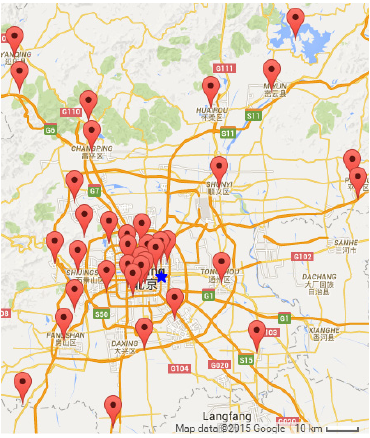
Figure 2. Distribution of Beijing observation stations. Blue star represents the US Embassy (39.92 N, 116.44 E) located in the city center.